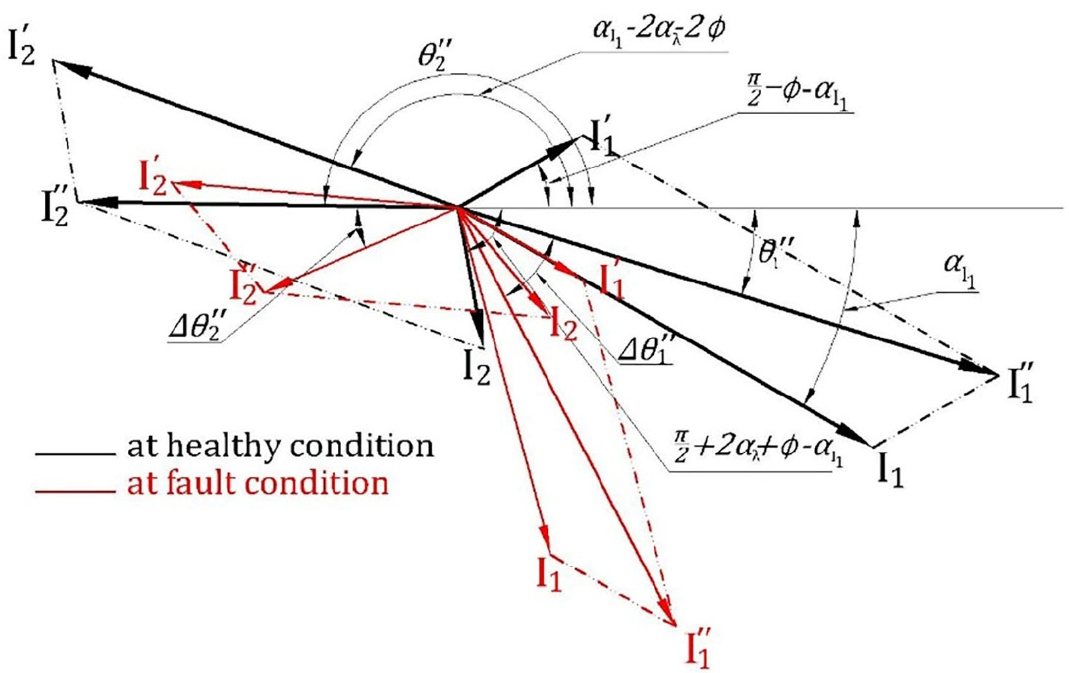
and i 2 current components. 2 1